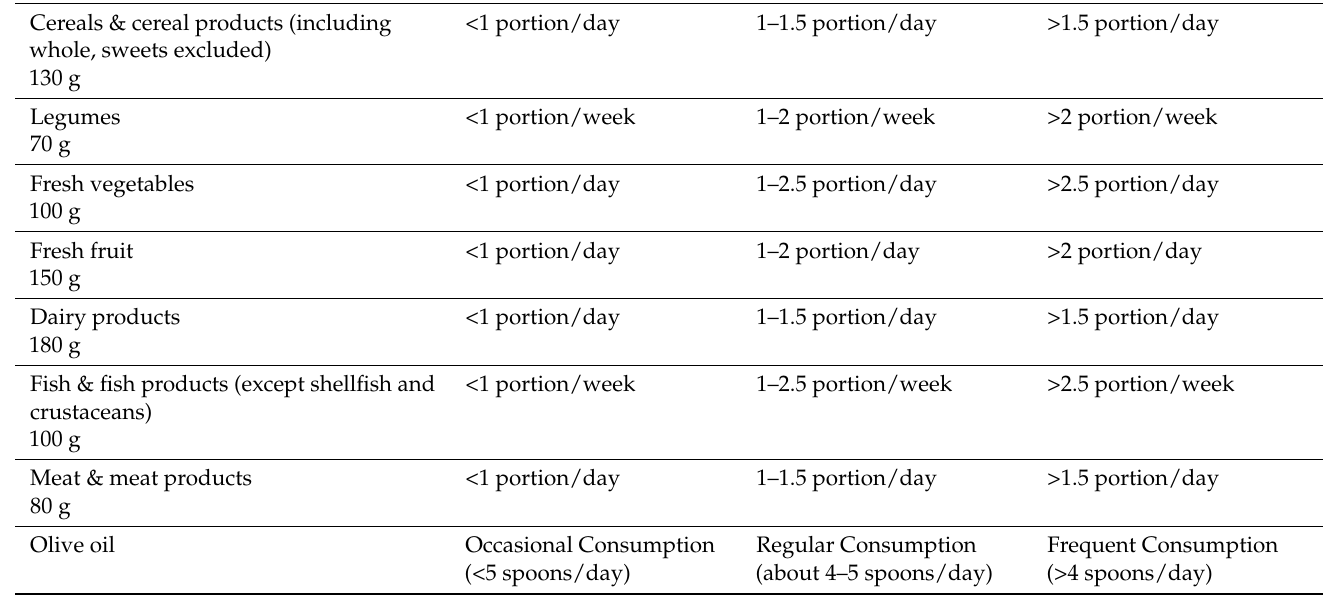
Table 1. Questionnaire for the evaluation of the adherence to the Mediterranean diet in adult population